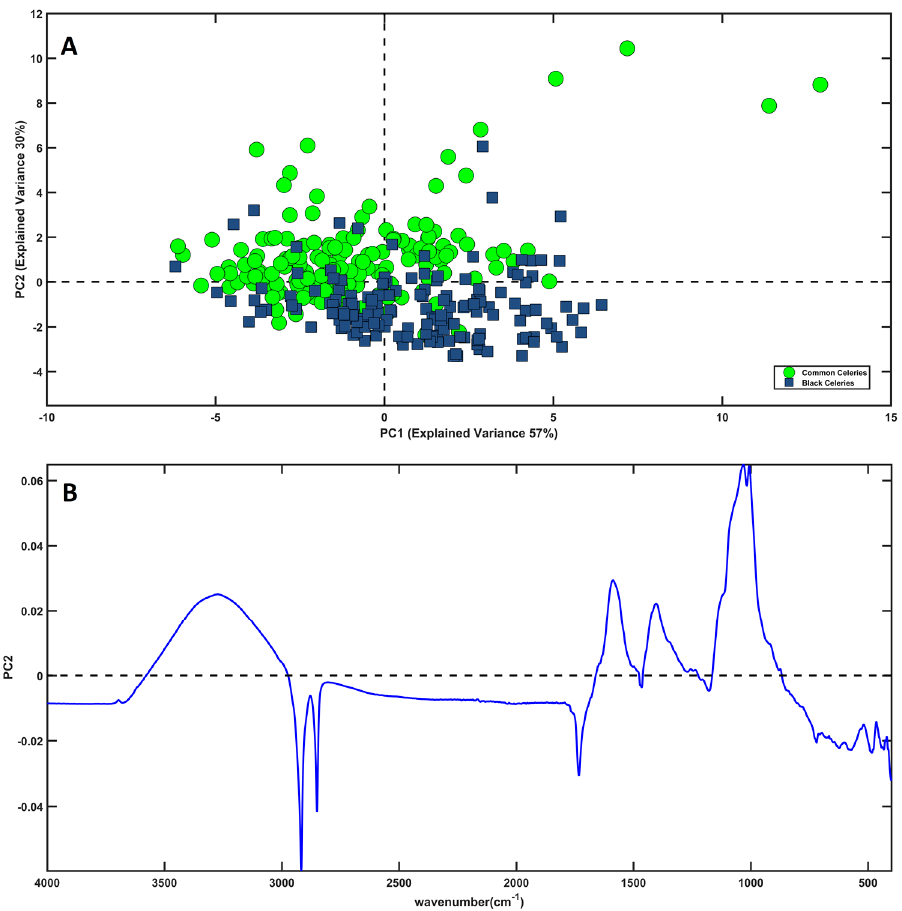
Figure 2. PCA. ( A ) Samples projected onto the space spanned by the first two PCs. Legend: Black Celeries—blue squares; Common Celeries—green dots; ( B ) Loading Plot of PC2.